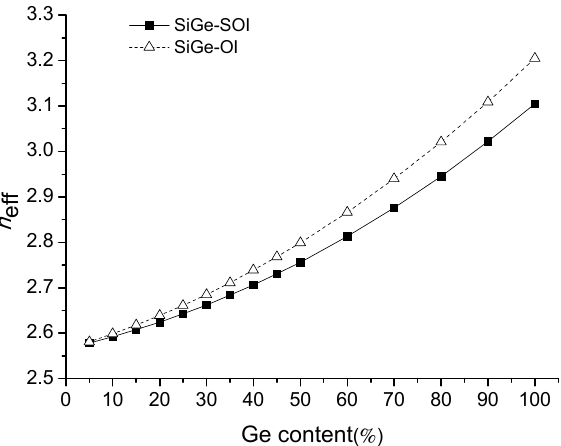
Figure 4. The relation curve between effective refractive index and Ge content at the wavelength of 1.55 μ m.